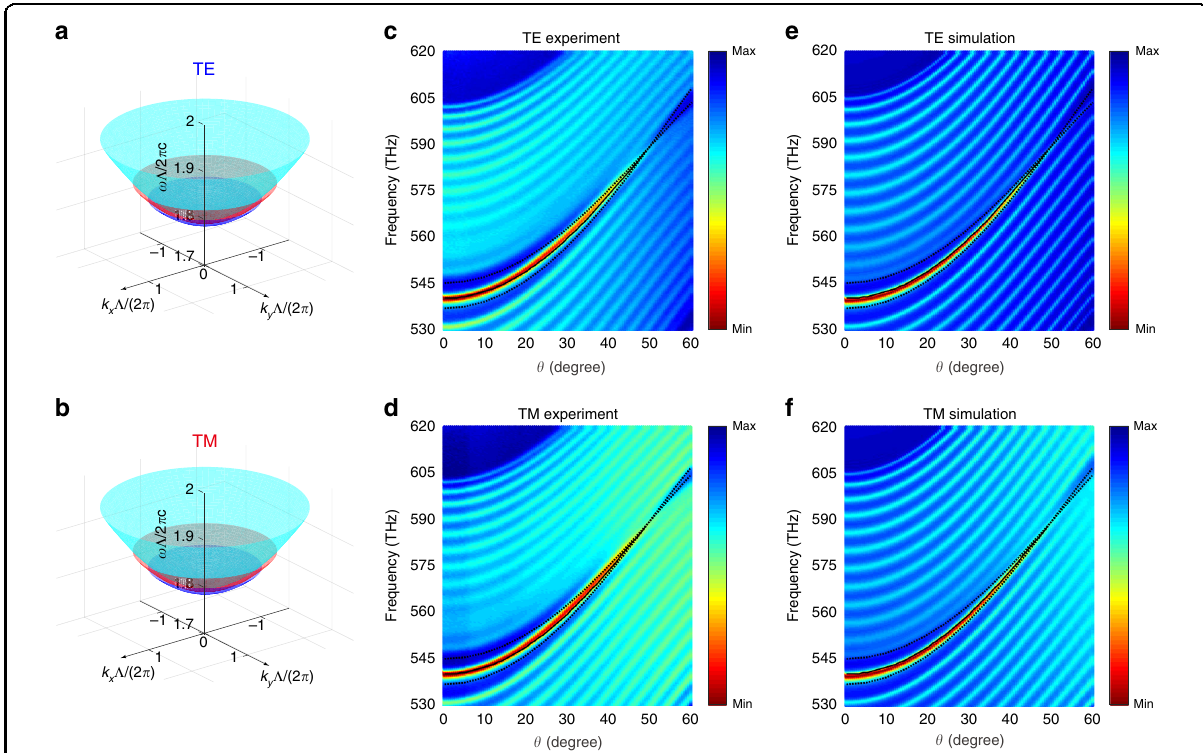
Fig. 3 Observation of the DBS. a , b Bowl surface state dispersion for a TE and b TM polarizations, in which the cyan, red, and dark blue surfaces indicate cases in which n A d A = n B d B equals 0.442, 0.422, and 0.415, respectively. n A d A þ n B d B remains constant in these simulations. In the experiment, n A d A = n B d B of our PC is 0.442. c , d Measured and e , f simulated re fl ection spectra for the silver fi lm/PC sample as the incident angle changes from 0 o to 60 o for TE and TM excitations. The black solid lines mark the numerically simulated bowl surface states dispersion, while the black dashed lines show the dispersion of the bulk PC bands. The PC shares identical dielectric properties with those shown in Fig. 2 but with slightly different thicknesses of d A = 402 nm and d B = 605 nm. The top layer of the truncated PC is layer B with d B = 2. The thickness of the silver fi lm on the top is 25 nm ( ± 5